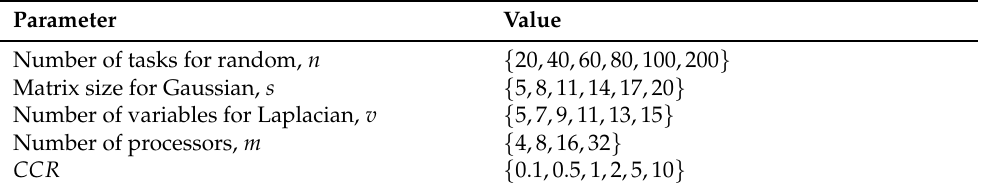
Table 2. Experimental parameters. CCR, communication-to-computation ratio.